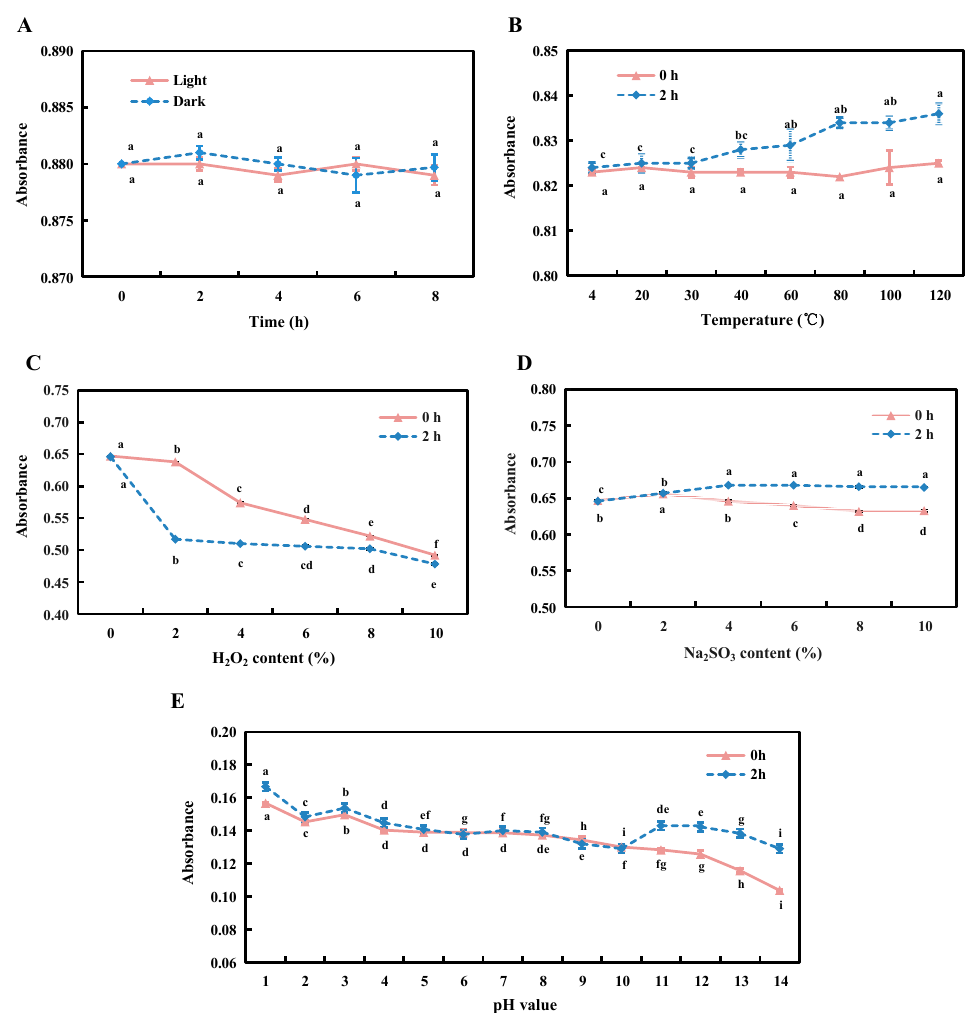
Figure 3. Effects of the different conditions on the stability of the pink pigment. The pink solid line and the blue dotted line in the figure indicate the changing trends of the absorbance of the pink pigment at 0 h and 2 h treatment, respectively. Light stability ( A ), temperature stability ( B ), oxidants stability ( C ), reducing agent on the stability ( D ) and pH stability ( E ) were measured. Different letters indicate significant differences in the pink pigment under different durations of the treatment at p < 0.05, and the error bars were expressed in the form of ±standard error (SE).